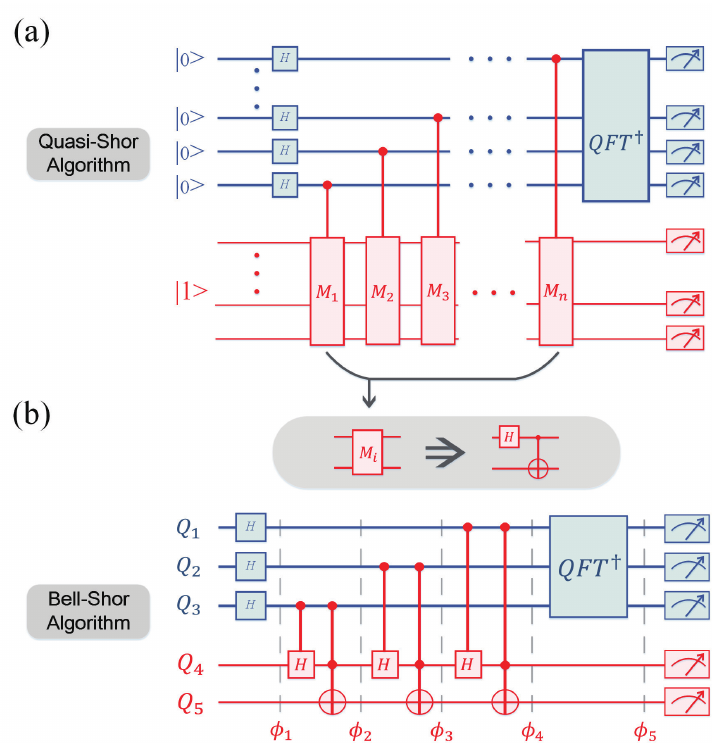
Figure 1. Schematic quantum circuit for quasi-Shor algorithms ( a ) and Bell–Shor algorithm ( b ).